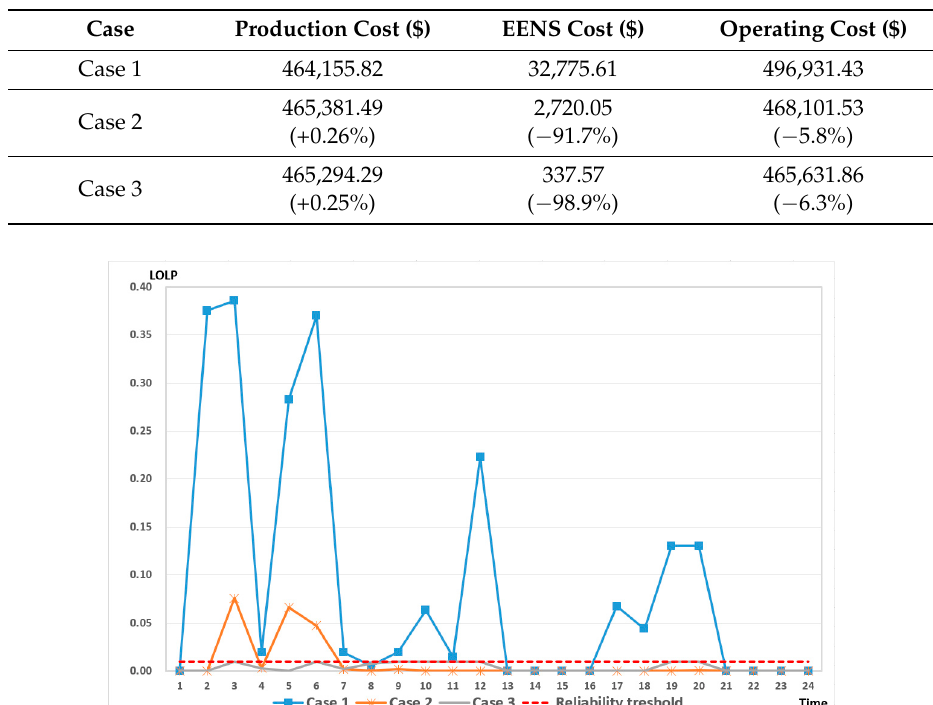
Figure 7. Hourly LOLP for the 24 h period.